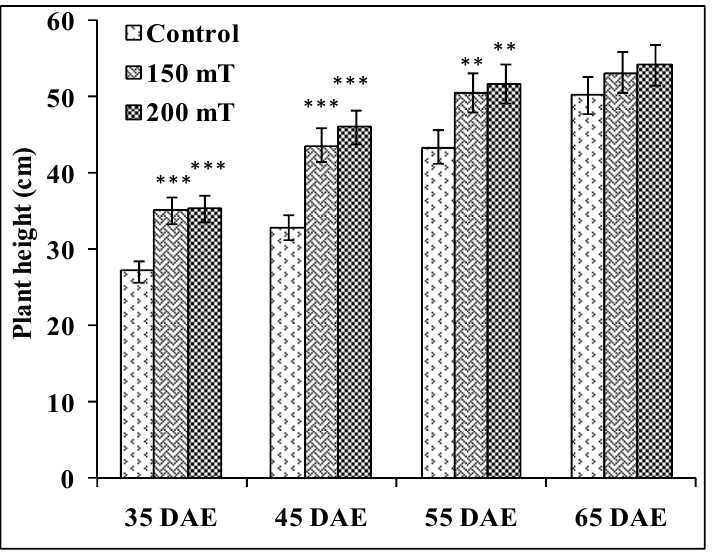
Figure 3. Effect of pre-sowing exposure of soybean seeds to magnetic field on plant height. *** and ** indicate significance at p < 0.001 and 0.01, respectively, compared to control.